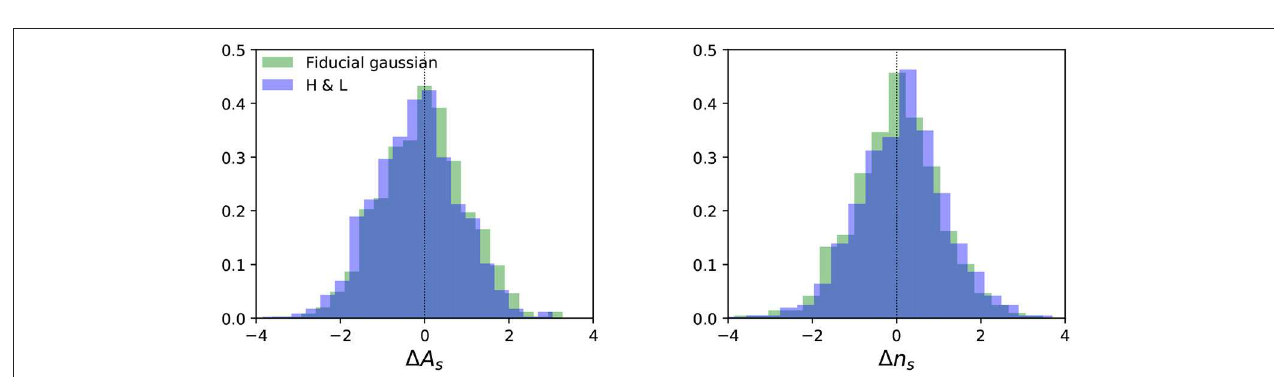
FIGURE 4 | Histograms of the biases for the parameters expectation values estimated from the power spectra of 1000 simulated partial-sky maps of CMB temperature anisotropies plus anisotropic noise. Biases are defined analogously to Figure 3 . We compare results from the fiducial gaussian and the Hamimeche-Lewis likelihood